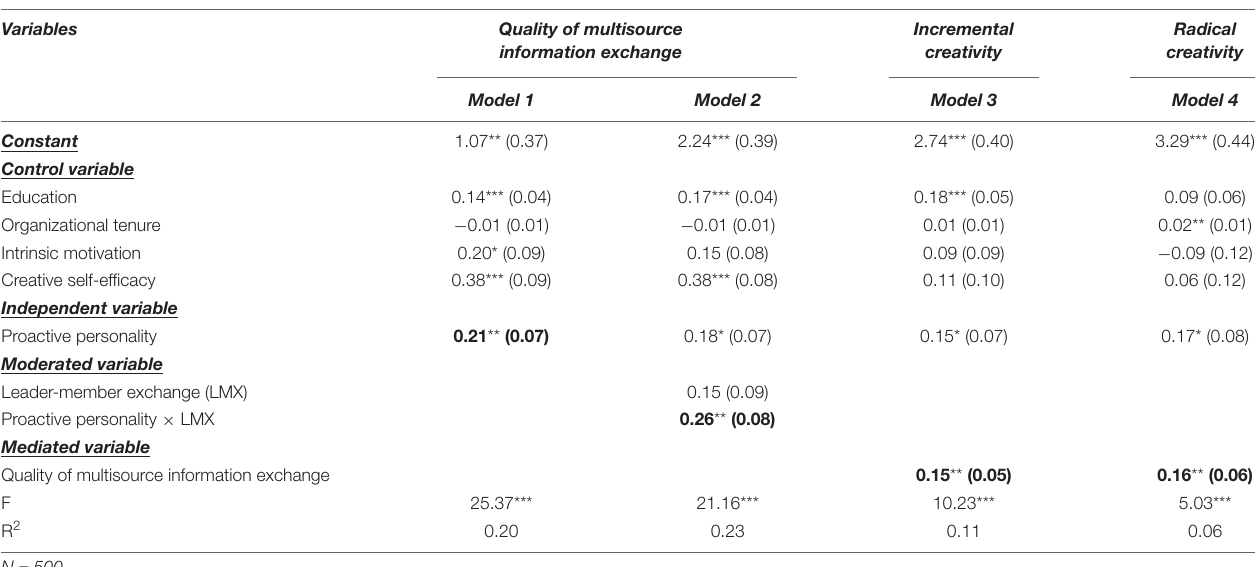
TABLE 4 | Hypotheses testing.